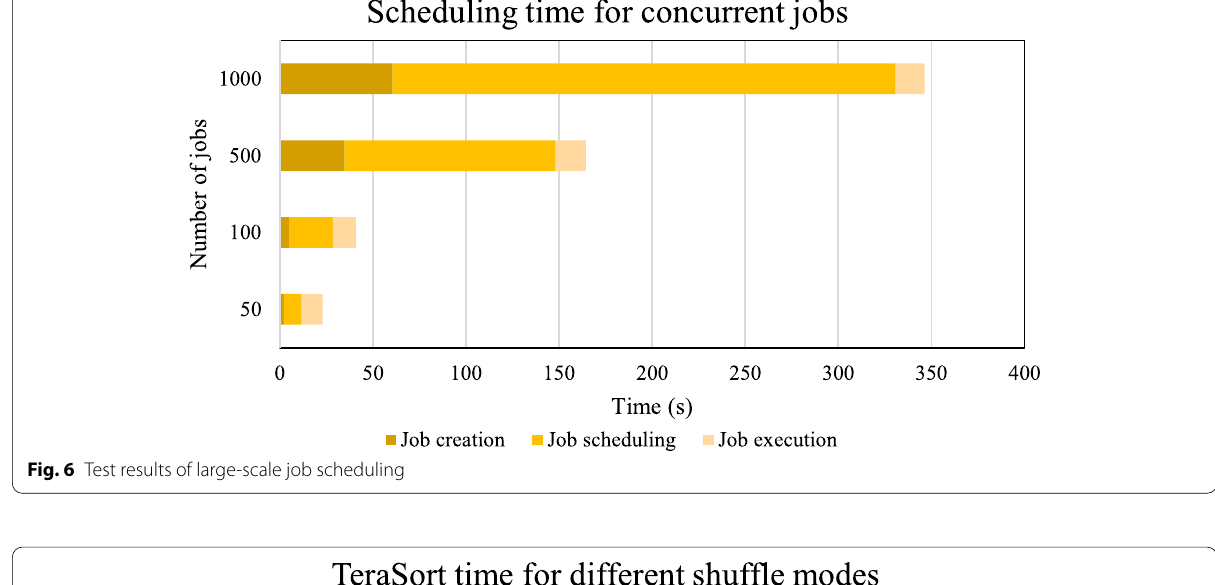
Fig. 6 Test results of large-scale job scheduling